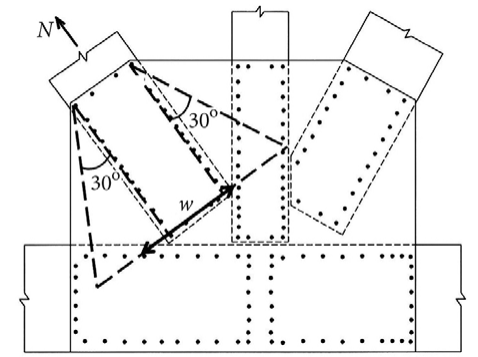
Fig. 6. Whitmore criterion of setting active gusset plate width